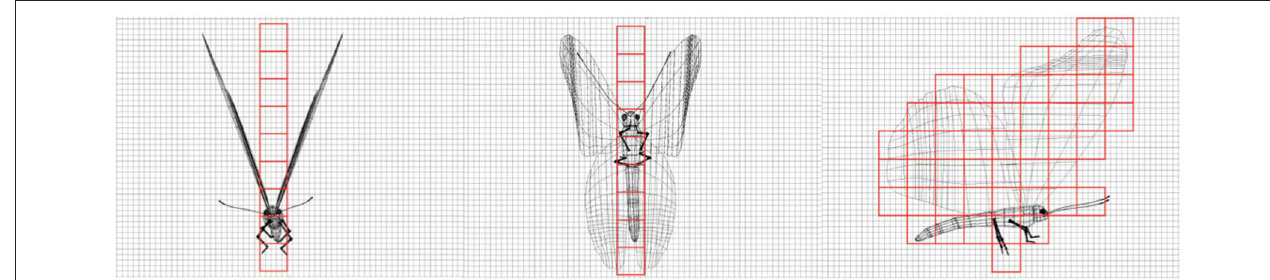
FIGURE 4 | Physically accurate 3D model of an individual monarch butterfly, which was created using scaled reference images of naturally dead monarch butterflies found at the survey sites. The model was used to calculate an estimate for the space occupied by an individual butterfly.